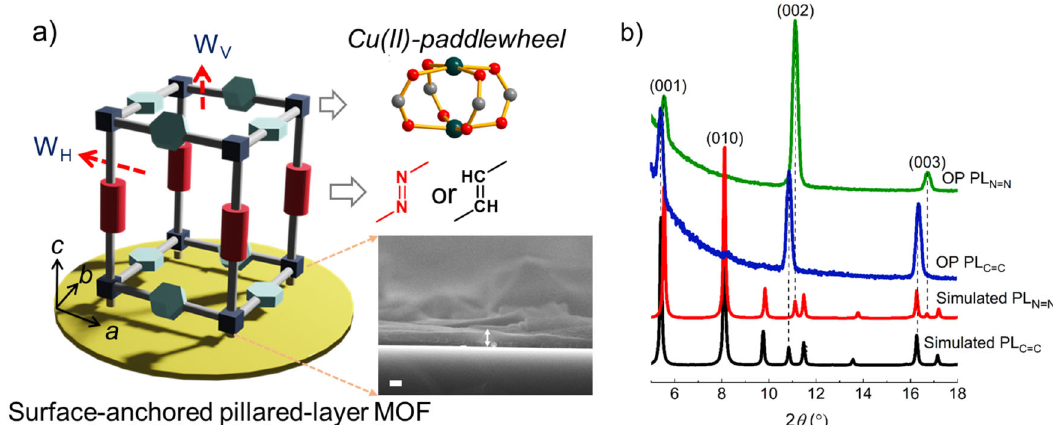
Fig.2|Designofthepillar-layeredMOFstructure. Structuralinsightofthemodel nanoporous MOF structure: a a pillared-layer surface-anchored MOF, with two distinctporewindowsW V andW H ;inset fi guresillustratethechemicalconstituents